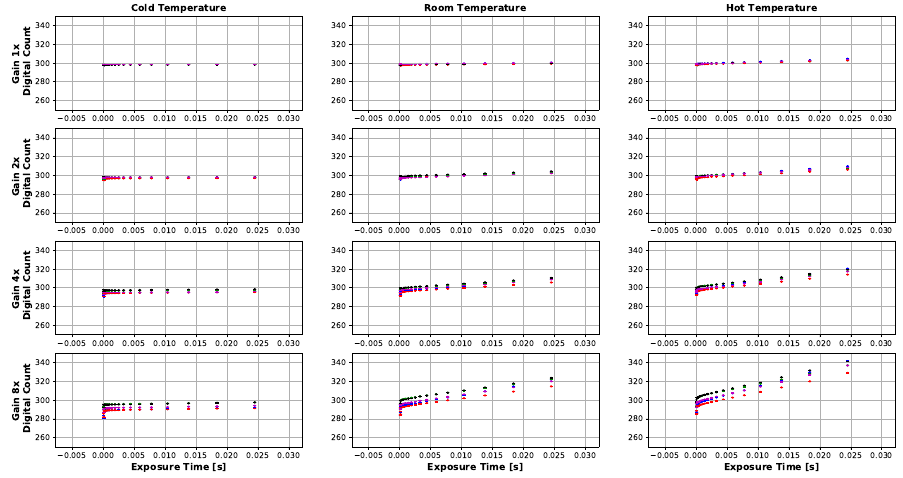
Figure 9. Average dark current (12-bit) produced by MicaSense RedEdge-3 sensor at various gains and exposure times. Each dot represents an average of at least 30 images. Bars are one standard deviation. Digital count values hold around 300 except for higher exposure times, gains and temperatures. The highest digital counts values seen were around 340 (24.5 ms, 8 × gain and 37.22 ◦ C).